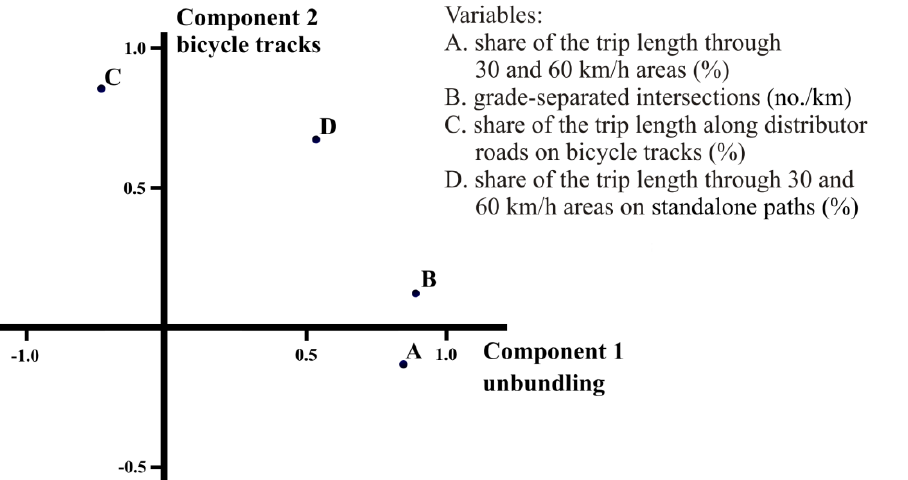
Figure 2. Factor loadings of the four independent variables on the unbundling and bicycle tracks factor Table 2. Descriptive Statistics for the Route Analysis Variables (N=66)